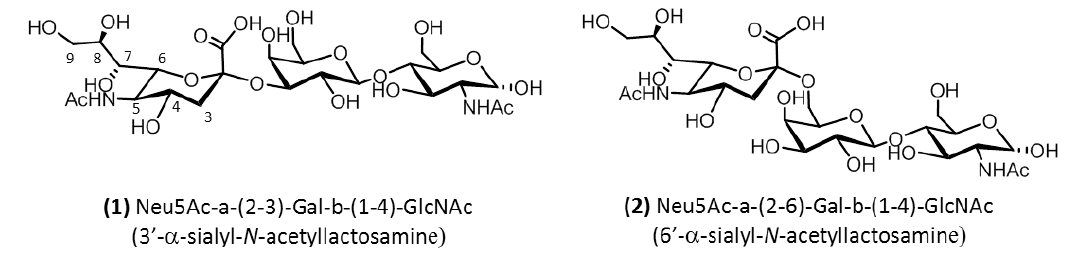
Figure 1. Structures of the α2 –3 ( a ) and α2 –6 ( b ) derivatives.